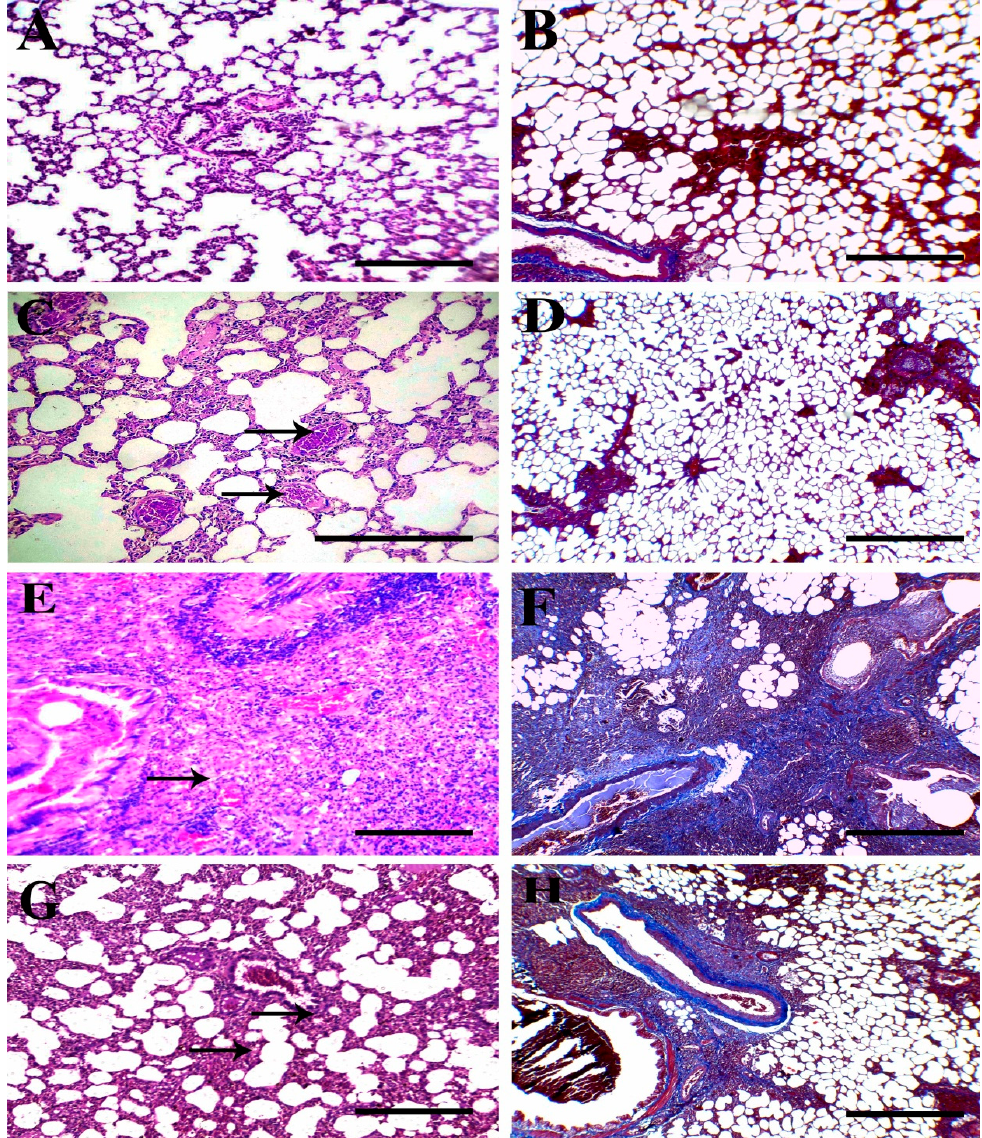
Figure 6. Representative photomicrograph of H&E and Masson’s trichrome (MT) stained sections from Wister rats’ lungs treated (via intratracheal administration) with bleomycin, TQ-PLGA-PVA-NPs, or their combination. ( A,B ) Lung sections from control rats showing normal histological architecture and normal limits of peribronchial collagen deposition. ( C,D ) Lung sections from TQ-PLGA-PVA-NP-treated rats showing slight thickening of interalveolar septa and congestion of interstitial blood capillaries (arrows). MT stained sections appeared without over collagen deposits around airways. ( E,F ) Lung sections from bleomycin-treated rats showing complete obliteration of pulmonary alveoli with proliferated spindle cells and variable amounts collagen fibers (arrows). The MT stained section revealed intense stainable blue collagen deposits. ( G,H ) Lung sections from bleomycin + TQ-PLGA-PVANP-treated rats showing partial improvement of lung tissues, with moderate infiltration of chronic mononuclear cells, predominantly lymphocytes, admixed with exfoliated epithelium (arrows). MT stained sections show moderate peribronchial and perivascular collagen depositions. Bar = 200 µm.